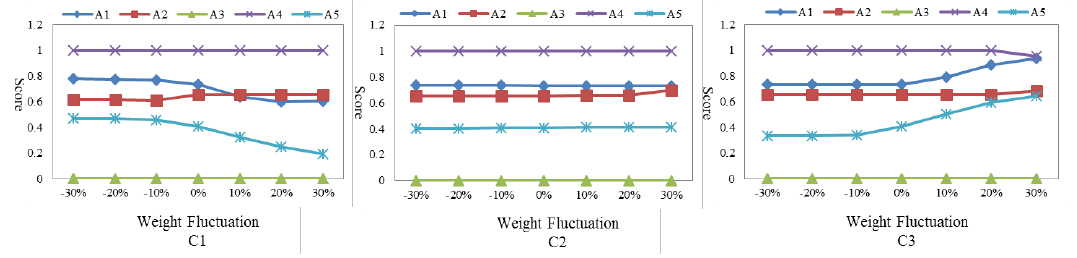
Figure 5. Sensitivity analysis results of sub-criteria in the economy group.